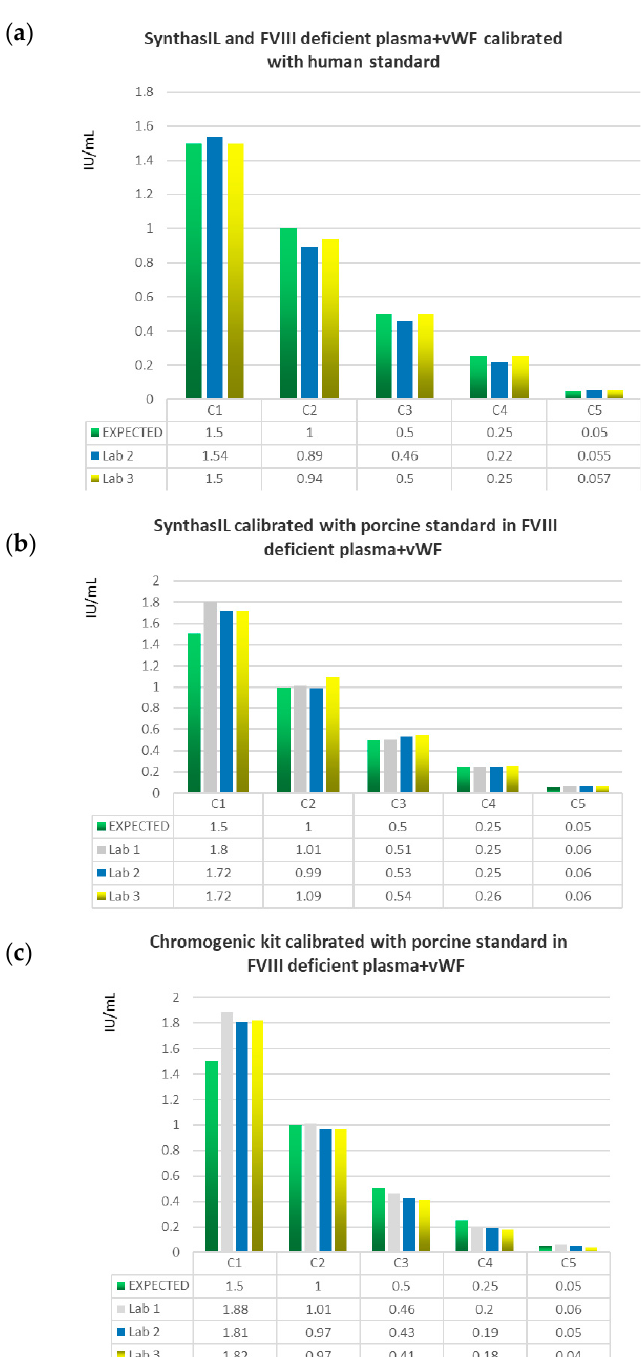
Figure 1. Histograms comparing the expected values of the five samples C1 = 1.5 IU/Ml, C2 = 1.0 IU/mL, C3 = 0.5 IU/mL, C4 = 0.25 IU/mL, C5 = 0.05 IU/mL) with the mean values obtained in each of the three laboratories with three different combinations of reagents: ( a ) SynthasIL with FVIII deficient plasma+VWF calibrated with human standard; ( b ) SynthasIL calibrated with porcine standard in FVIII deficient plasma+VWF; ( c ) Coamatic kit calibrated with porcine standard in FVIII deficient